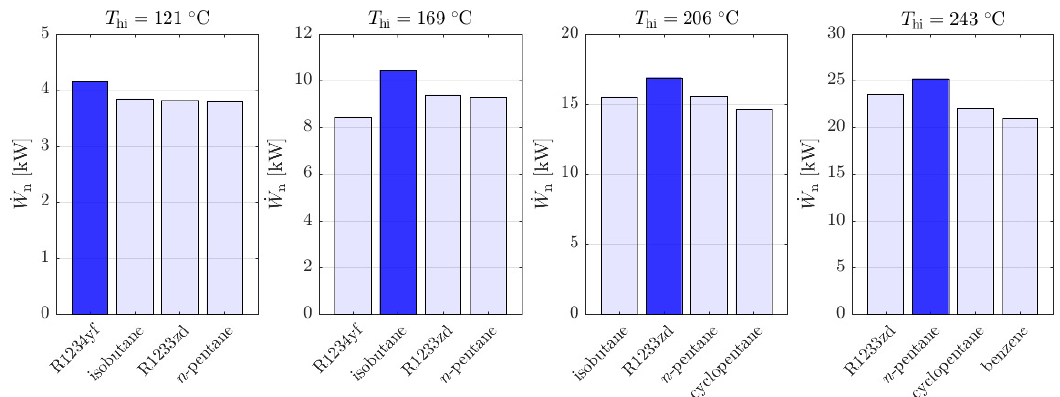
Figure 11. Effect of selecting a working fluid with a non-optimal critical temperature on the power output from the system. In each plot, fluids are plotted in order of increasing critical temperature, with the dark blue bars representing the optimal fluid identified using the Peng–Robinson model, from left to right: T hi = 121 ◦ C, 169 ◦ C, 206 ◦ C and 243 ◦